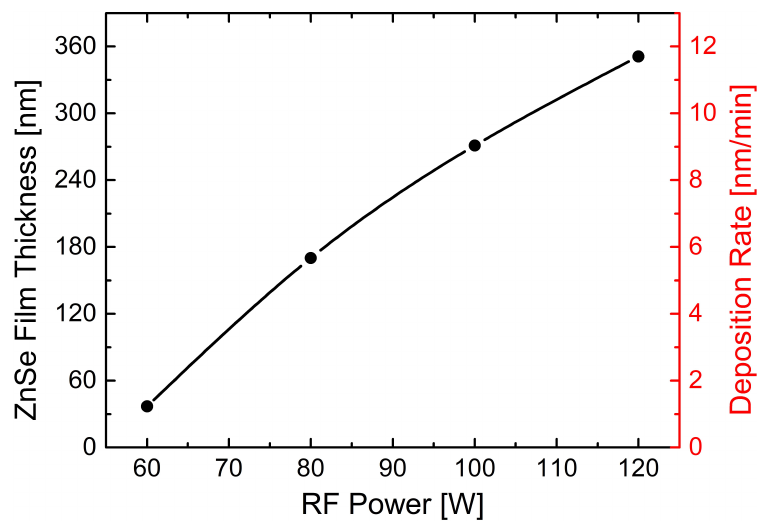
Figure 5. Variation of ZnSe films thickness with RF power, in given sputtering conditions as described in the text. The curve is based on the SEM analysis of the samples. Corresponding calculated sputtering rate is indicated in nm/min on the right red Y-axis.